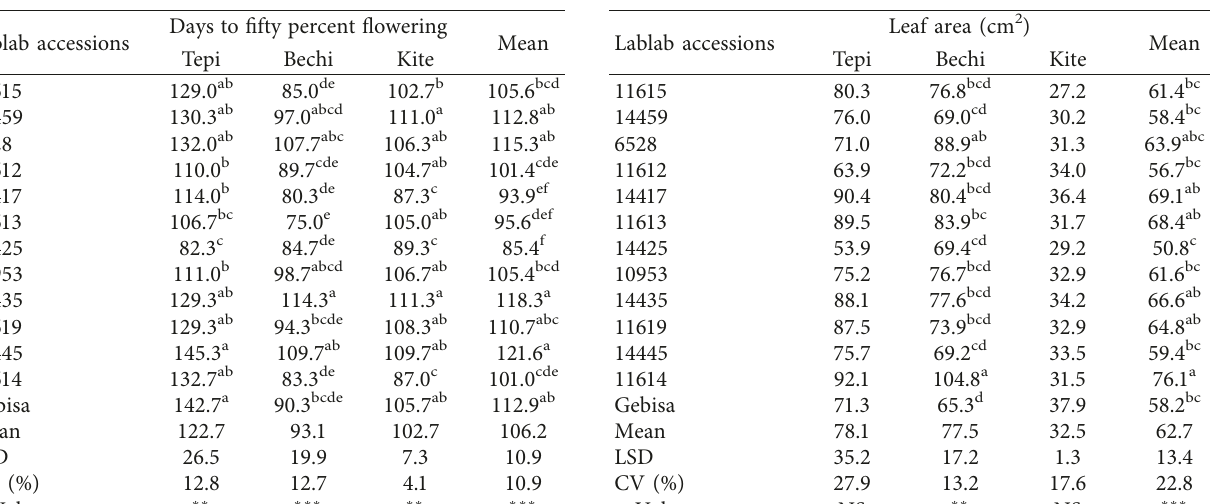
Table 5: Average leaf area at the stage of forage harvest (50% flowering) at Tepi, Bechi, and Kite testing